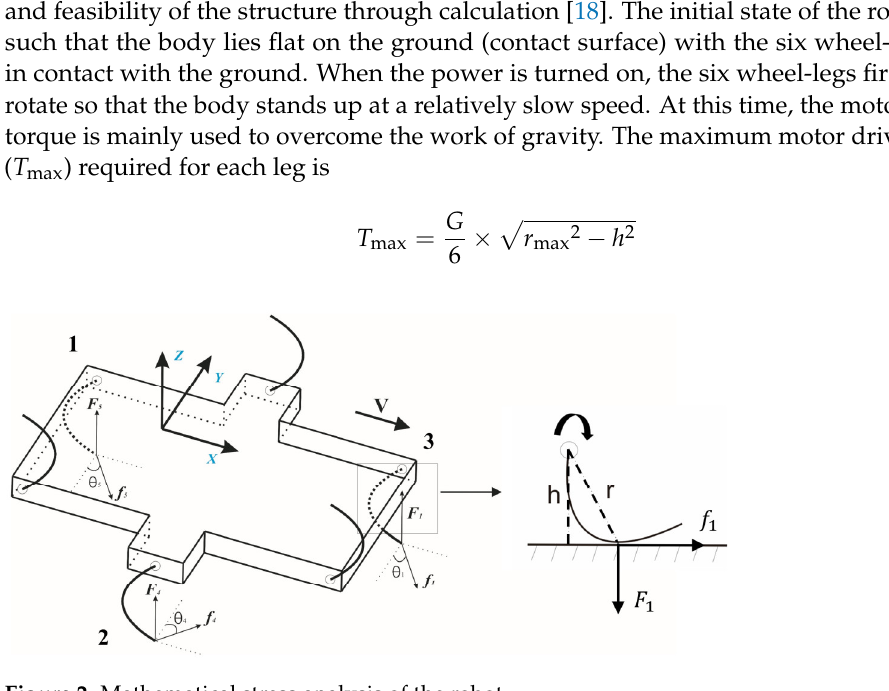
Figure 2. Mathematical stress analysis of the robot.